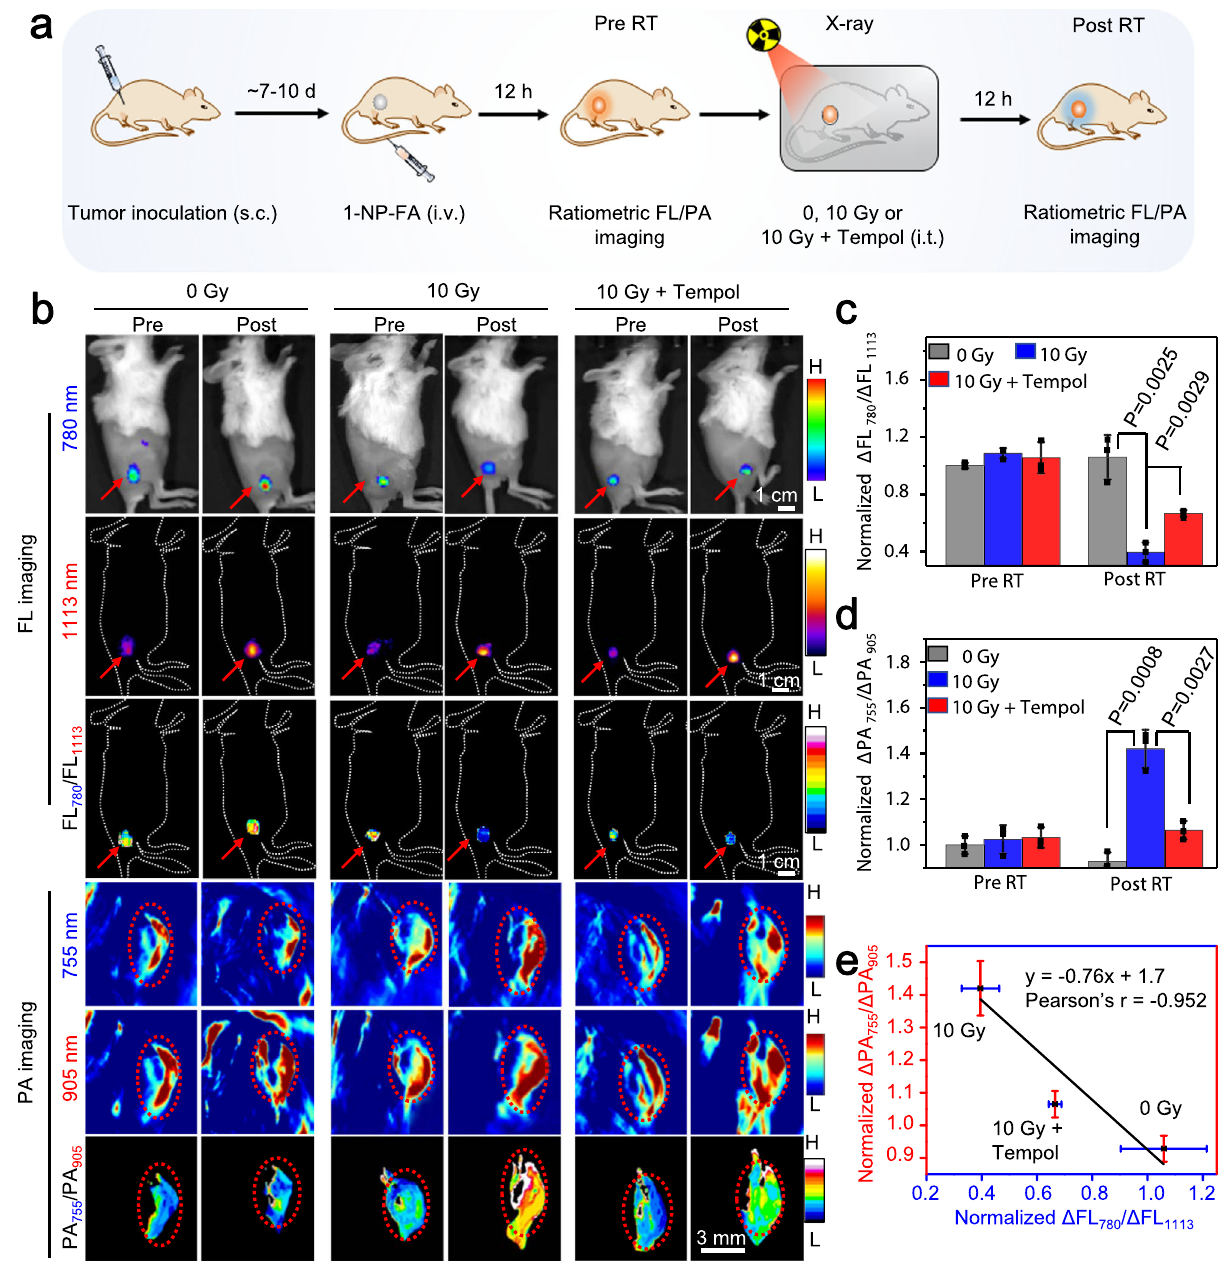
Fig. 6 Ratiometric bimodal imaging of (cid:129) OH production in 4T1 tumors undergoing X-ray RT. a Schematic for noninvasive ratiometric fl uorescence/ photoacoustic (FL/PA) imaging of (cid:129) OH in 4T1 tumor-bearing mice upon radiotherapy (RT) with X-ray. 4T1 tumor-bearing mice were intravenous (i.v.) injected with 1-NP-FA (1.68/0.05/0.6 mM 1-Br-Et/NIR775/IR1048, 200 μ L). After 12 h, the FL and PA images were acquired (Pre RT). The tumors were then unirradiated (0 Gy) or irradiated with X-ray (10 Gy, 1.0 Gy min − 1 for 10 min); to inhibit tumor (cid:129) OH, the mice were intratumorly (i.t.) injected with tempol (50 mg kg − 1 ), and then irradiated with X-ray (10 Gy). After another 12 h, the FL and PA images were acquired (Post RT). b FL, PA, and corresponding ratiometric FL or PA images of 4T1 tumors following indicated treatment. Red arrows and circles indicate the tumor locations. c Normalized Δ FL Δ FL Δ PA Δ PA 780 / 1113 ratios and d normalized 755 / 905 ratios in 4T1 tumors following indicated treatment . e Plot of the normalized versus normalized Δ PA 755 / Δ PA 905 ratios shows a good correlation ( r = − 0.952) between them in 4T1 tumors upon indicated treatment. Data are presented as mean ± s.d. ( n = 3 independent mice). Statistical differences were analyzed by Student ’ s two-sided t -test. Source data are provided as a Source Data fi